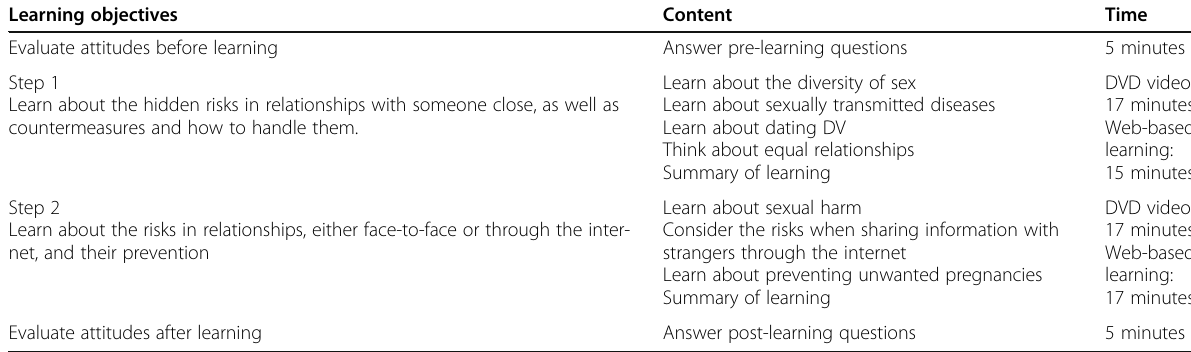
Table 1 Learning objectives and content by DVD video teaching materials and a web-based learning program Learning